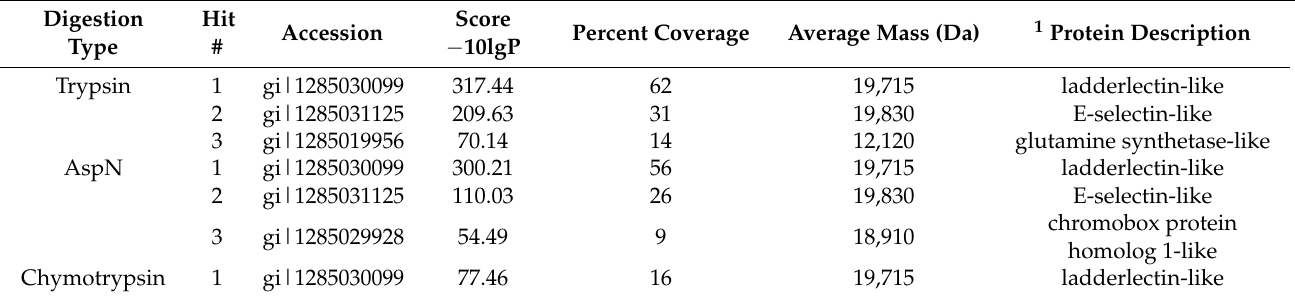
Table 1. PEAKS identification searches of protein spot IS25 from Colorado potato beetle (CPB) abdominal contents, pH 4–7, 13 cm strip (cut to 7 cm).